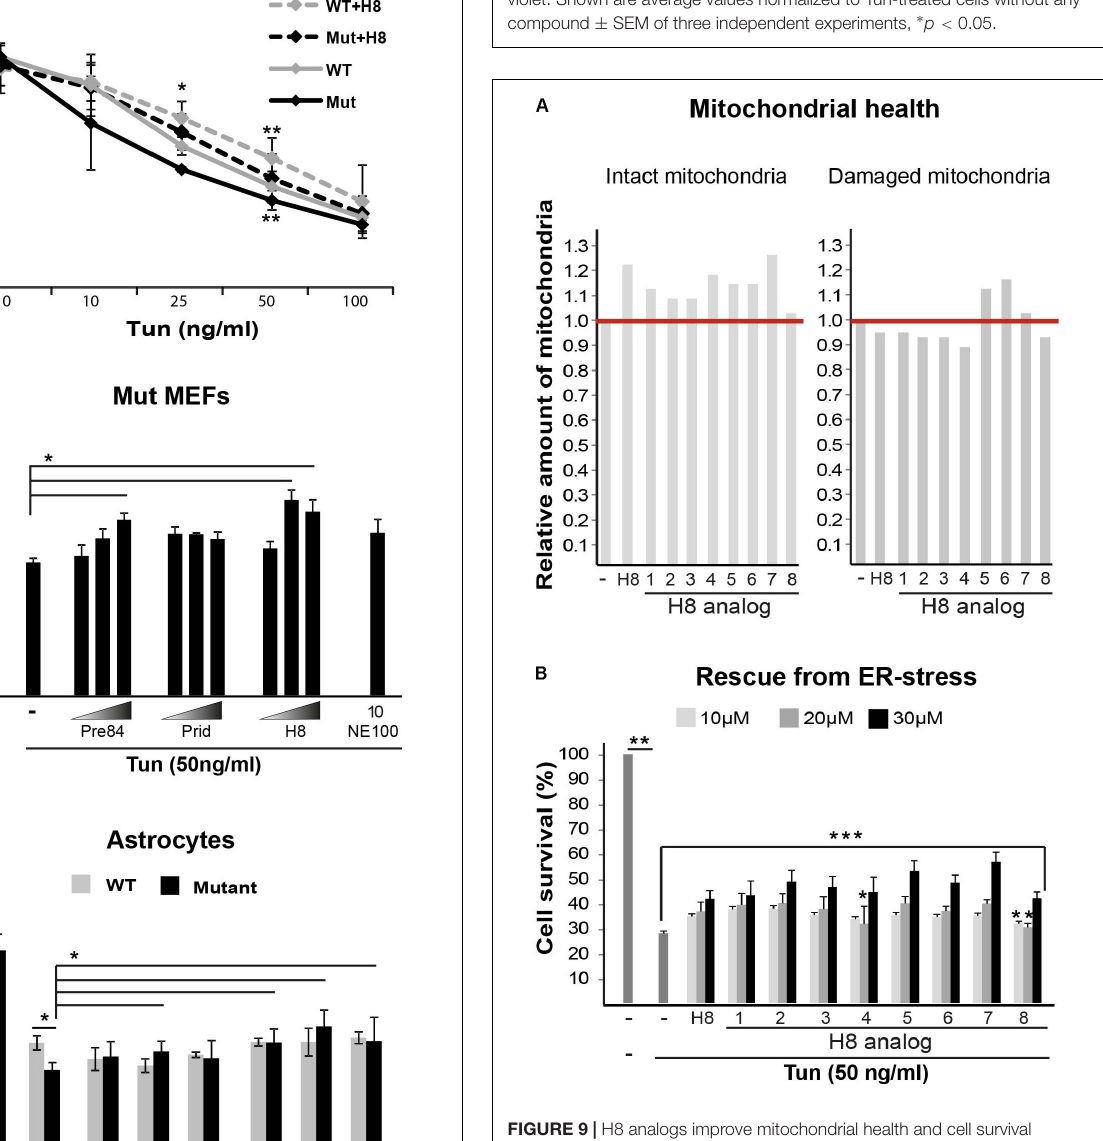
FIGURE 9 | H8 analogs improve mitochondrial health and cell survival following Tunicamycin-induced ER stress. (A) Mut MEFs incubated or not for 24 h with 10 µ M of the indicated compounds ( Table 1 ), followed by Hoechst and JC1 staining and analysis for intact and damaged mitochondria as described in Figure 1 . (B) Mut MEFs incubated or not with the indicated concentrations of the indicated compounds for 2 h followed by addition of 50 ng/ml Tun for additional 22 h incubation and then stained with crystal violet. Shown are average values normalized to Tun-treated cells without any FIGURE 8 | S1R binders improve cell survival upon ER stress. (A) WT and compound ± SEM of three independent experiments. ∗ not significant; Mut MEFs were pretreated or not for 2 h with 20 µ M H8 followed by addition ∗∗ p < 0.02; ∗∗∗ p < of the indicated concentrations of Tunicamycin (Tun) for additional 22 h. Cell survival was determined by crystal violet staining. Shown are average values normalized to untreated controls ± SEM of three independent experiments. ∗ p < 0.05 for Mut vs. WT at 25 ng/ml Tun; ∗∗ p < 0.05 for WT+H8 vs. WT and for Mut+H8 vs. Mut at 50 ng/ml Tun. (B,C) Mut MEFs (B) or WT and Mut astrocytes (C) were pretreated or not for 2 h with the indicated compounds at the indicated concentrations ( B : 10, 20, 30 µ M; C : 20, 30, 50 µ M), followed ( Continued )